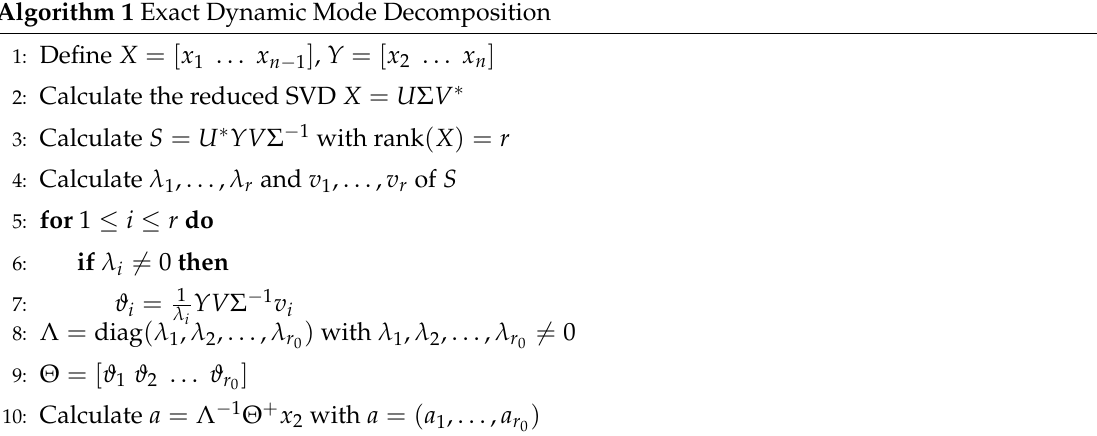
Algorithm 1 Exact Dynamic Mode